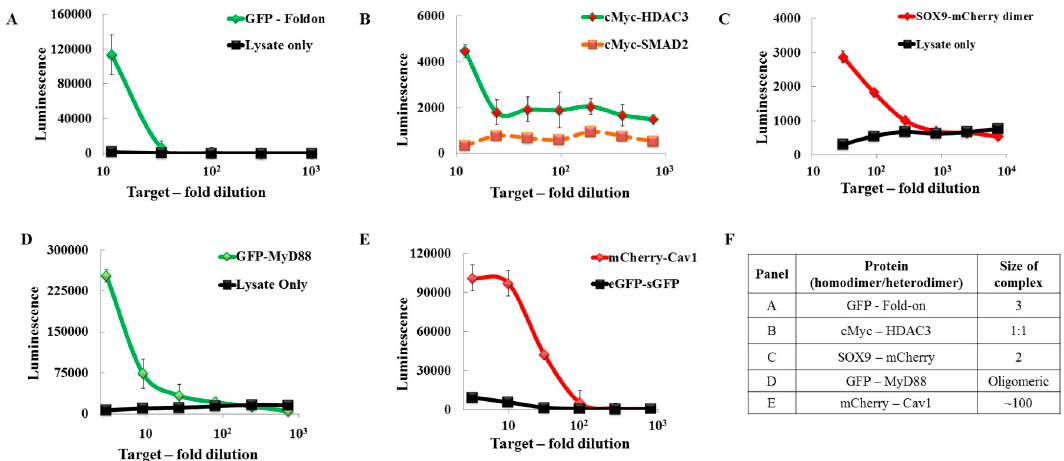
Figure 4. Applying the split-luc reporter to PPI and self-dimerising/oligomerising proteins. ( A ): Graphical representation of split-luc assays performed on the sGFP–Foldon protein. sGFP–Foldon is a trimer wherein GFP trimerizes post-expression due to the foldon domain. We could detect a high luminescence signal over the background for sGFP–Foldon using the GL–GS SLN pair; ( B ): Graphical representation of split-luc assays performed on the cMyc (b/HLH/Zip)–HDAC3 heterodimer. For this assay, cMyc and HDAC3 were co-expressed in Leishmania cell-free lysate and their serial dilutions were used in the split-luc assay using the LC–GS SLN pair. As a negative control, the non-interacting protein pair cMyc–SMAD2 (dotted line) was used; ( C ): Graphical representation of split-luc assays performed on the SOX9–mCherry homodimer. The SLN pair of CL–CS was used for this assay with a lysate-only control used to detect background luminescence; ( D ): Graphical representation of split-luc assays performed on MyD88 using the GL–GS SLN pair; ( E ): Graphical representation of split-luc assay performed on mCherry–Cav1 using the LC–CFRS SLN pair. As a measure of background luminescence, the eGFP–sGFP homodimer was used; ( F ): Expected stoichiometry of each target